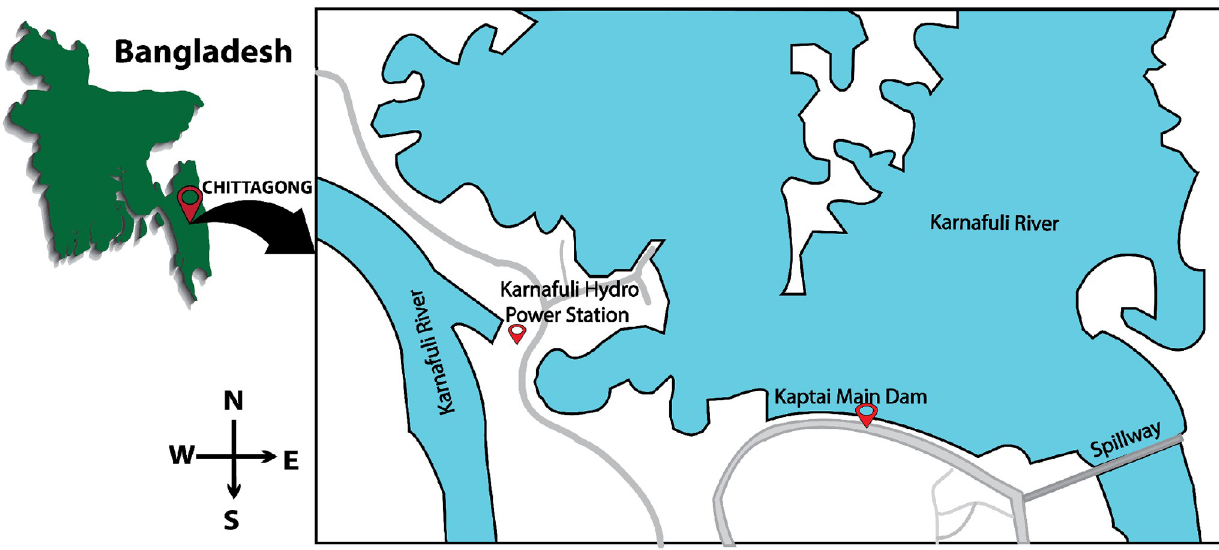
Fig 1. The site map of Karnafuli Hydro Power Station (picture is drawn in Illustrator according to the geographical location).